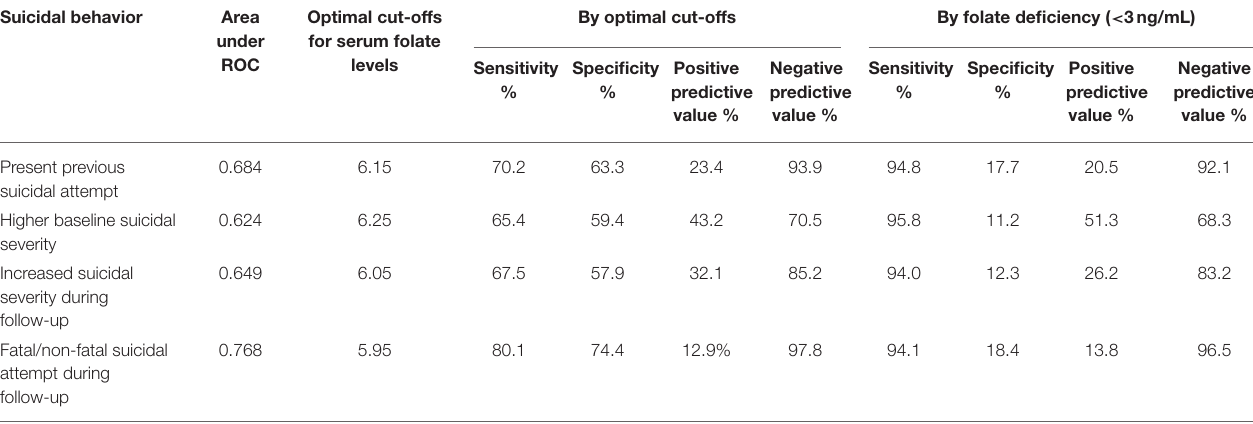
TABLE 3 | Results of receiver operating curve (ROC) analyses for serum folate levels with suicidal behavior. Suicidal behavior Area Optimal cut-offs By optimal cut-offs By folate deficiency ( < under for serum folate ROC levels